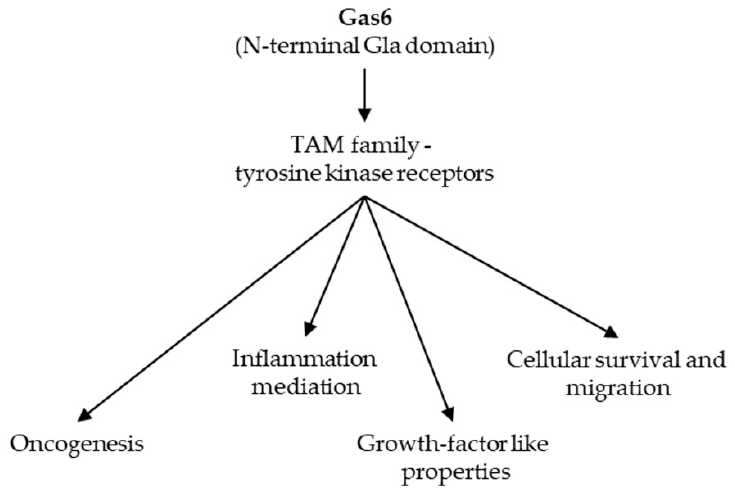
Figure 4. General mechanism of action for Gas6. Abbreviations: Gas6, growth arrest specific protein 6; TAM, Tyro3-Axl-Mer.